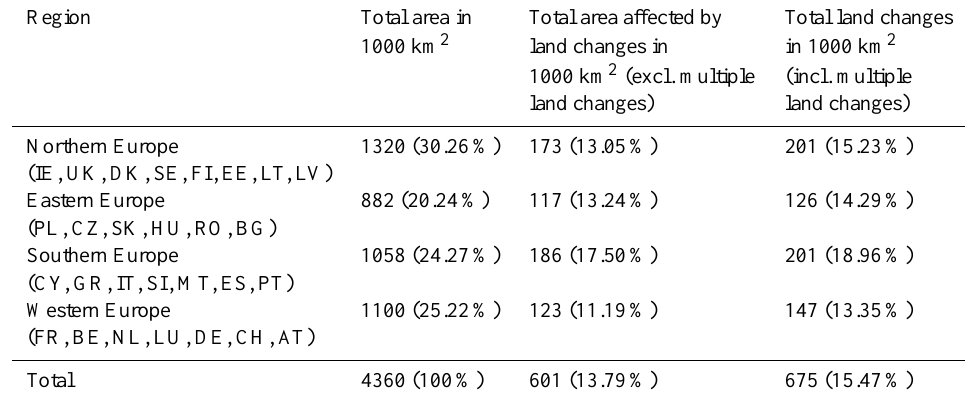
Table 2. Land change amounts for four different European regions and EU27+Switzerland for the period from